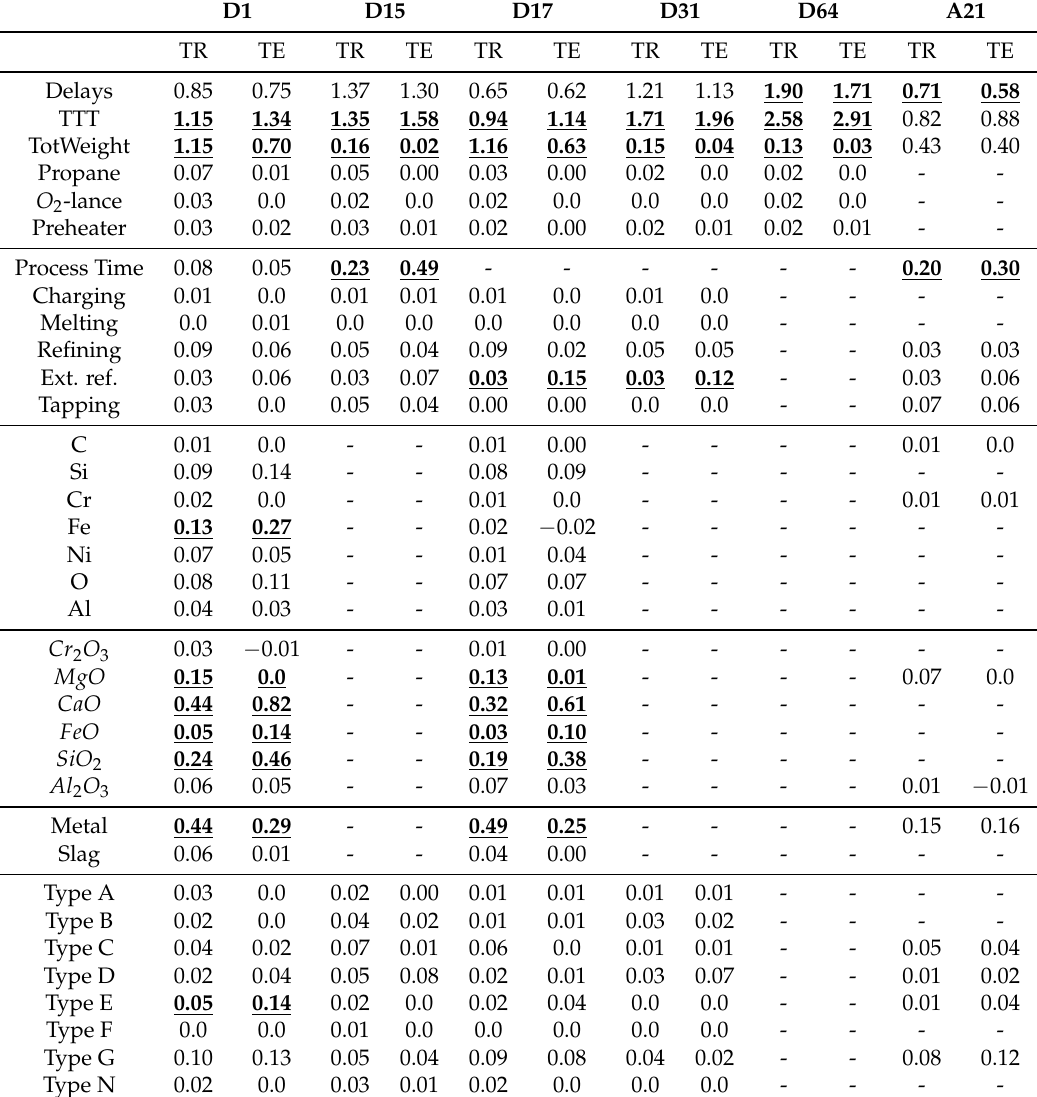
Table 13. Feature importance (FI) for the selected models. Models called D are from the Domain approach and models called A are from the algorithmic approach. TR and TE are short for training and test, respectively. Significant changes in FI are indicated in underlined bold